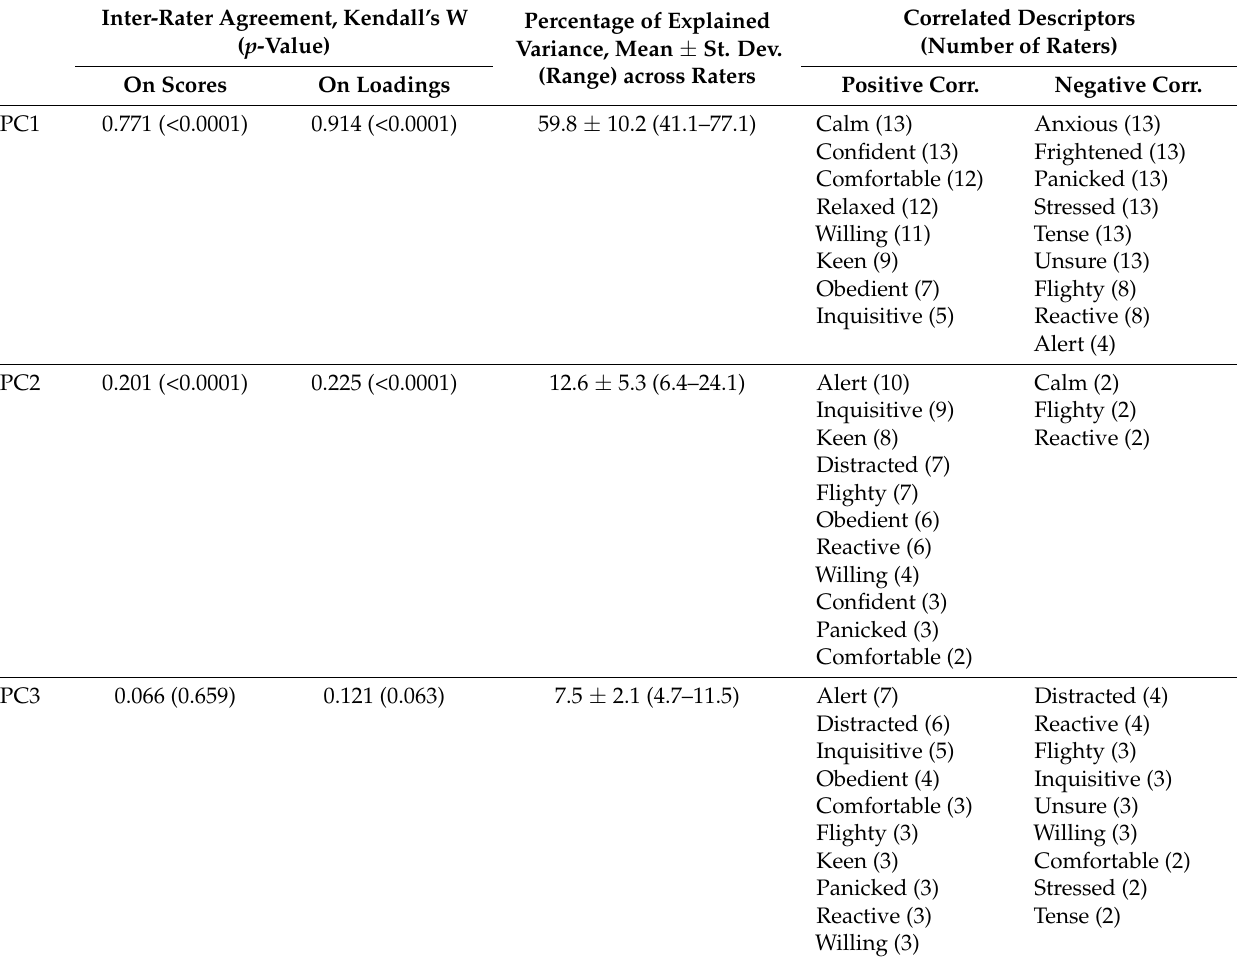
Table 4. Summary results of PCA of the descriptors. Lists of correlated descriptors include only those with a loading ≥ 0.2 in absolute